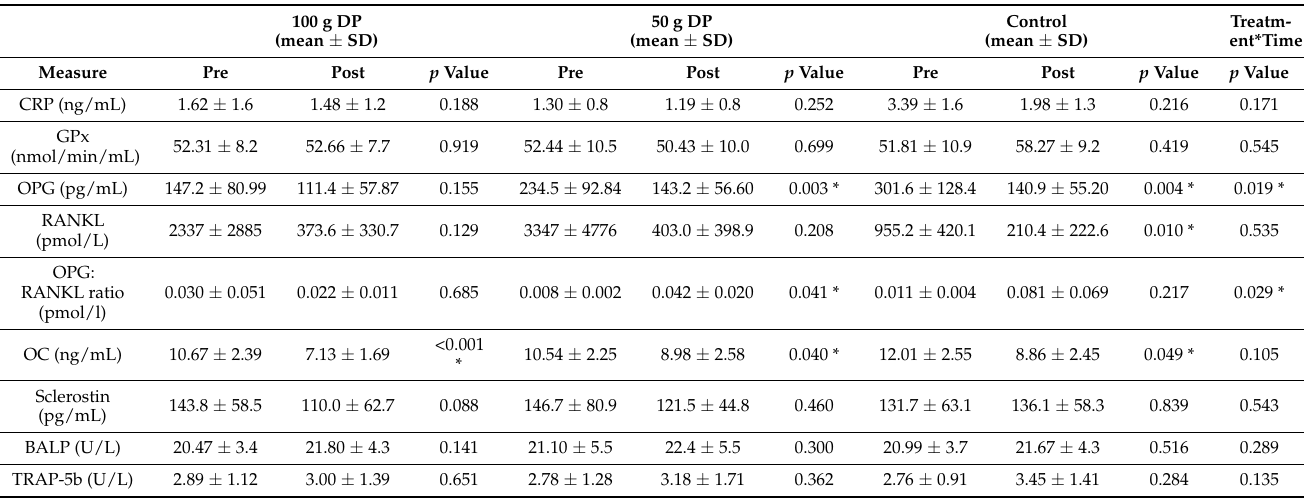
Table 5. Biomarkers of inflammation and bone health from baseline (Pre-) to 3 months (Post).